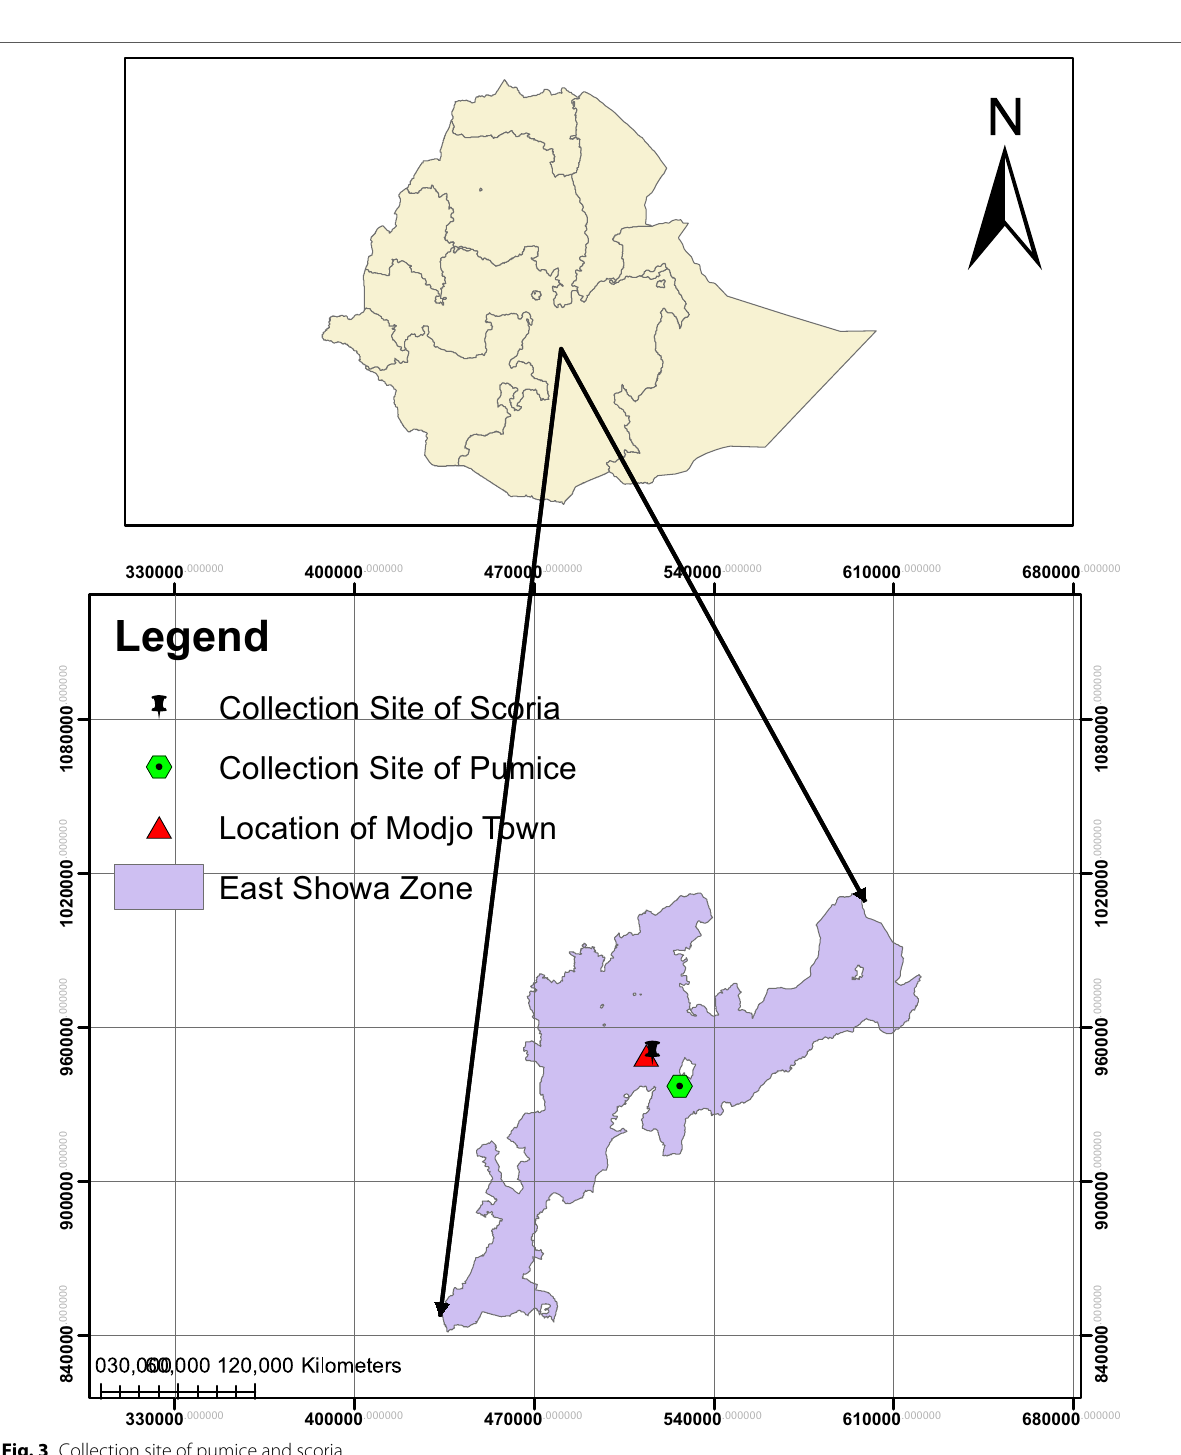
Fig. 3 Collection site of pumice and